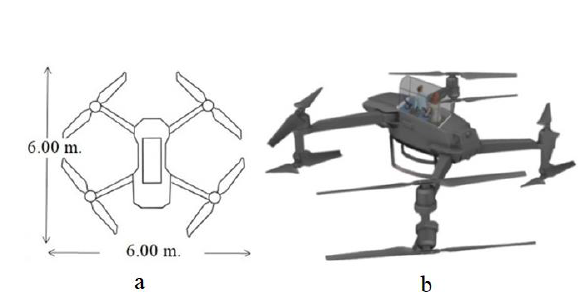
Figure 4 . a. The first SAV project idea. b. First basic model mainframe.